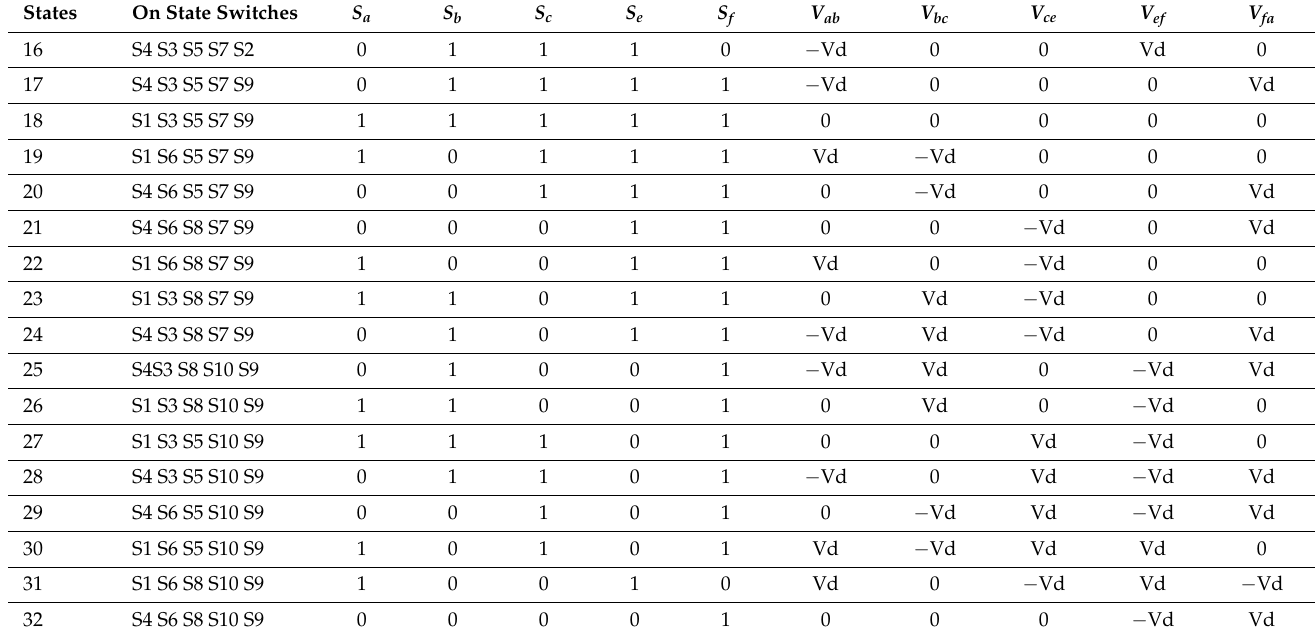
Figure 1. Modeling of five ‐ phase inverter.